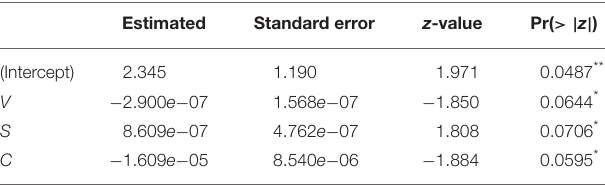
TABLE 6 | Regression results for soil management as soil factor.